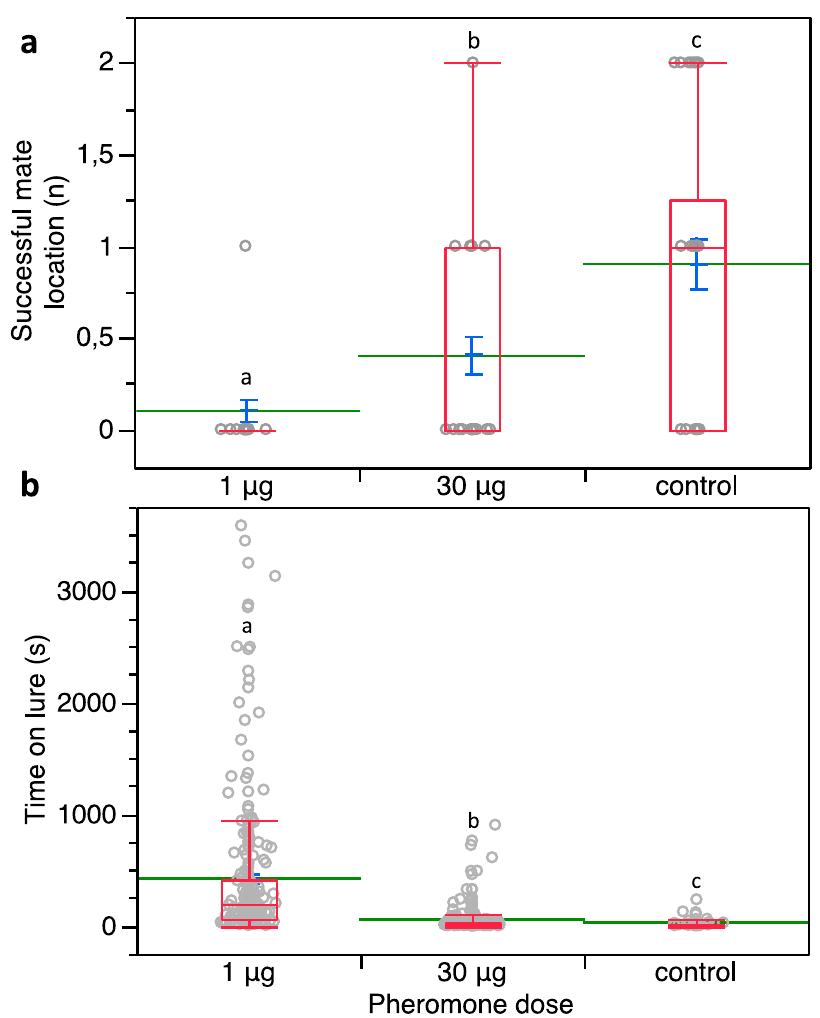
Figure 6. ( a ) Number of successful mate locations by P. calceolariae males surrounded by two different loadings of sex pheromone on 16 rubber septa at 2 cm spacing. ( b ) Time spent by P. calceolariae males on lures loaded with 1 or 30 µ g of synthetic sex pheromone and control ones. Box plots indicate the median (line) within each box and the range of dispersion (lower and upper quartiles and outliers). Green lines and blue T-bars indicate means and standard errors, respectively. Above each box plot, different letters indicate significant differences (Steel-Dwass test, p < 0.05).